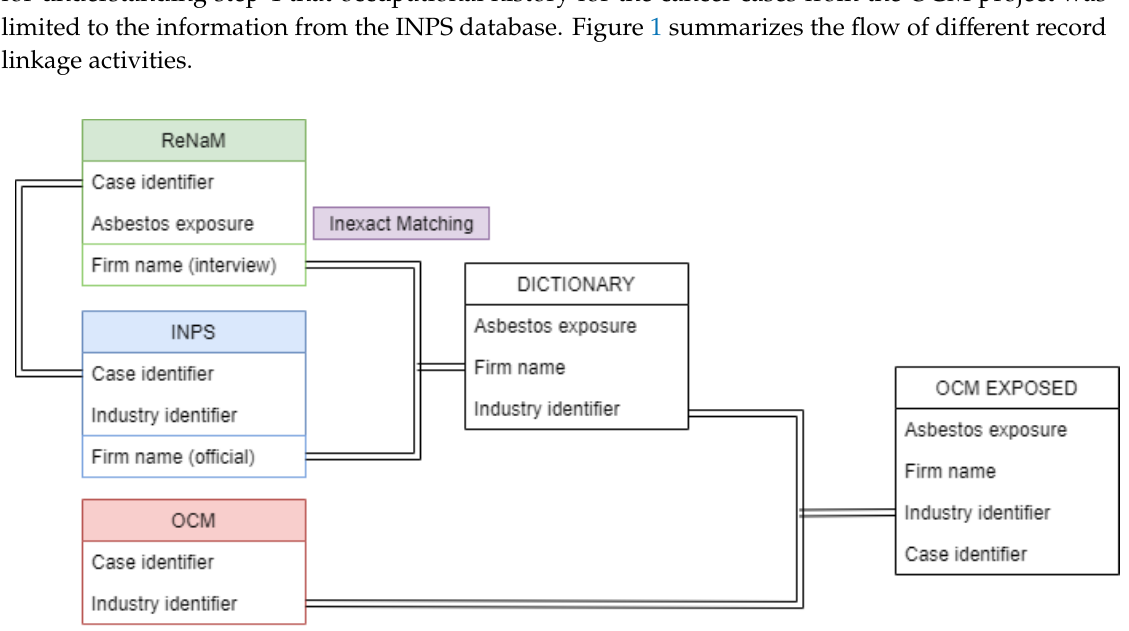
Figure 1. Graphical description of the different record linkage activities. ReNaM—The National Mesothelioma Registry; INPS—Italian National Social Security Institute; OCM—Occupational Cancer Monitoring.